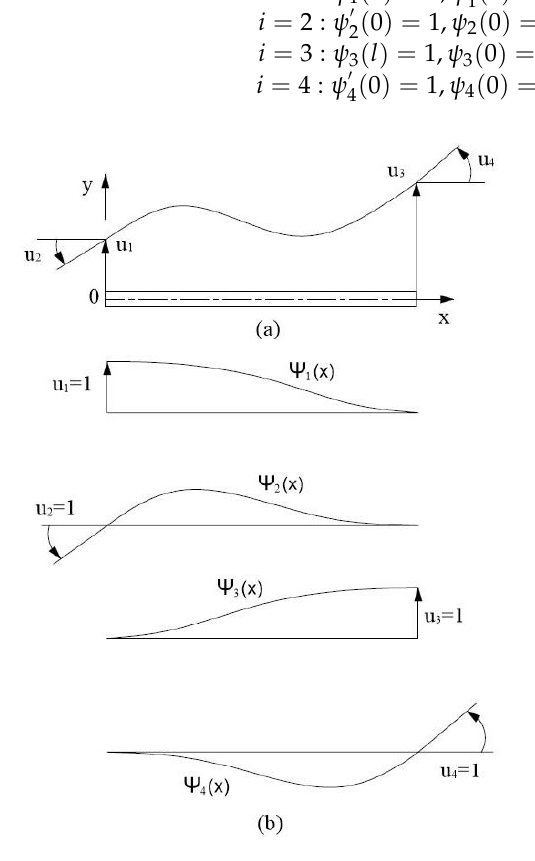
Figure 2. Beam cell model, ( a ) beam cell degrees of freedom, ( b ) interpolation